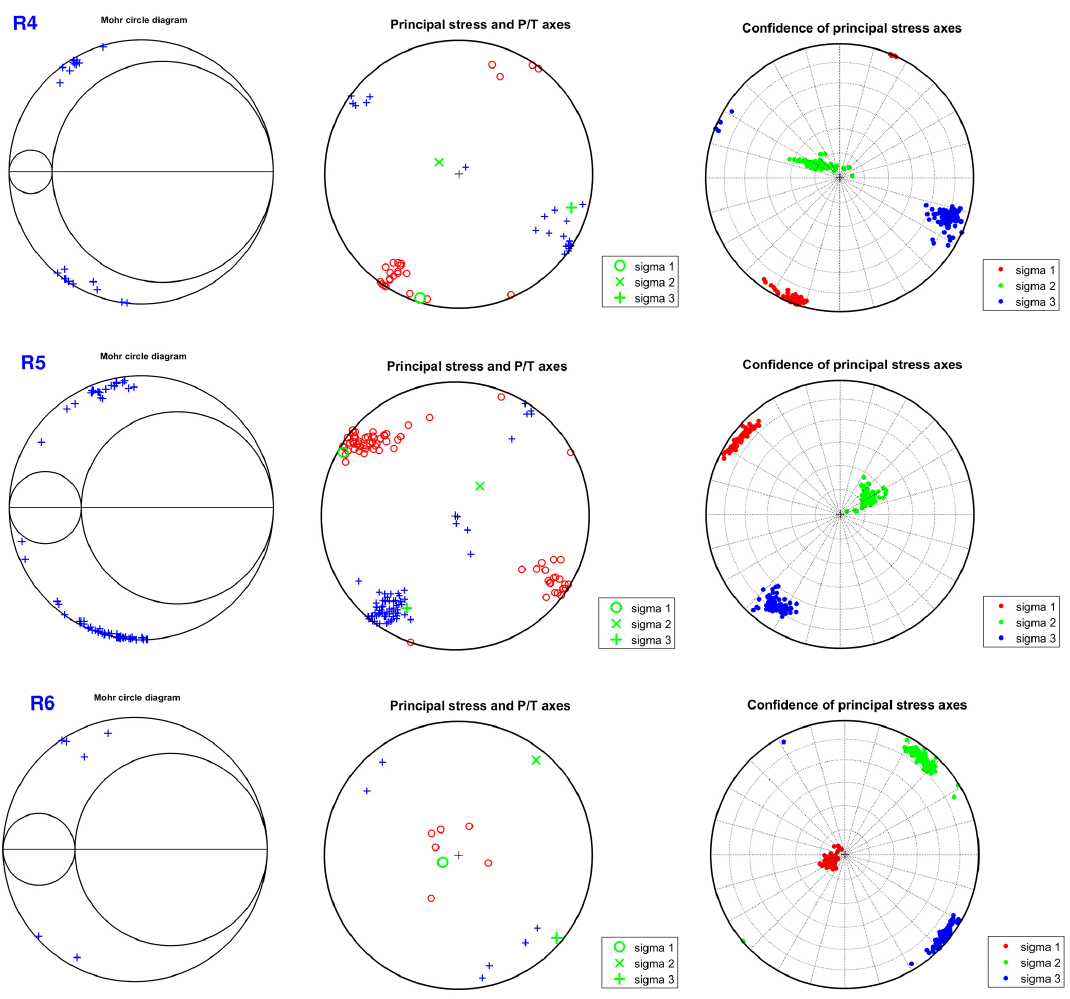
Figure 9. Mohr circle diagrams for all the regions (left column). P and T axes distributions for all the regions (right column). Red circles represent pressure, while blue crosses represent